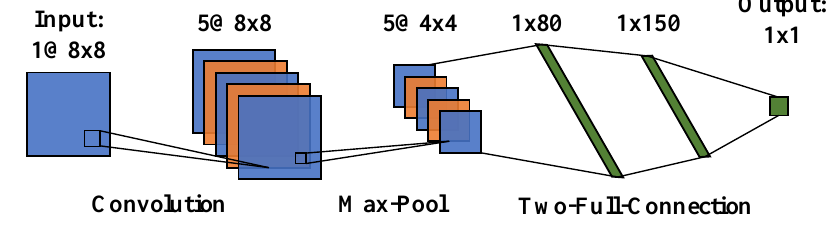
Figure 2. Structure of the convolution neural network.